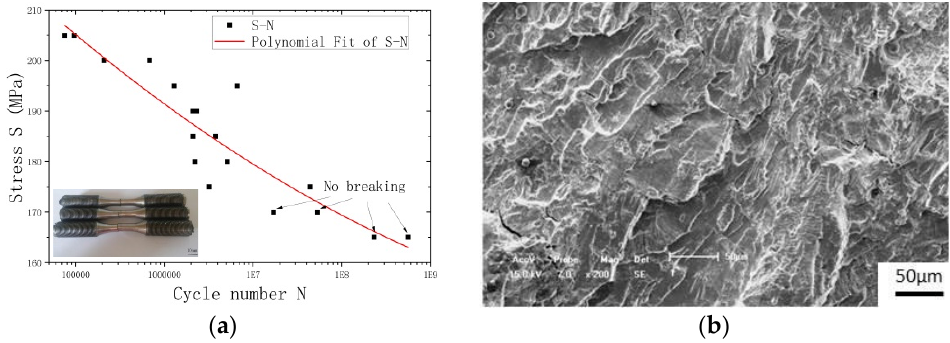
Figure 8. High cycle fatigue stress-number curve of a press-bonded Q235/304 joint: ( a ) the stress- number curve; ( b ) a SEM fractograph of the transgranular crack propagation in a sample fractured under 200 MPa after 2.1 × 10 5 cycles.